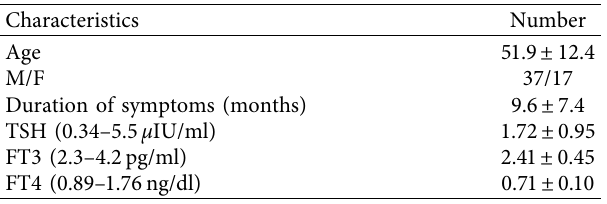
Table 1: Te clinical information and preoperative thyroid function results of the 54 NFPA patients combined with